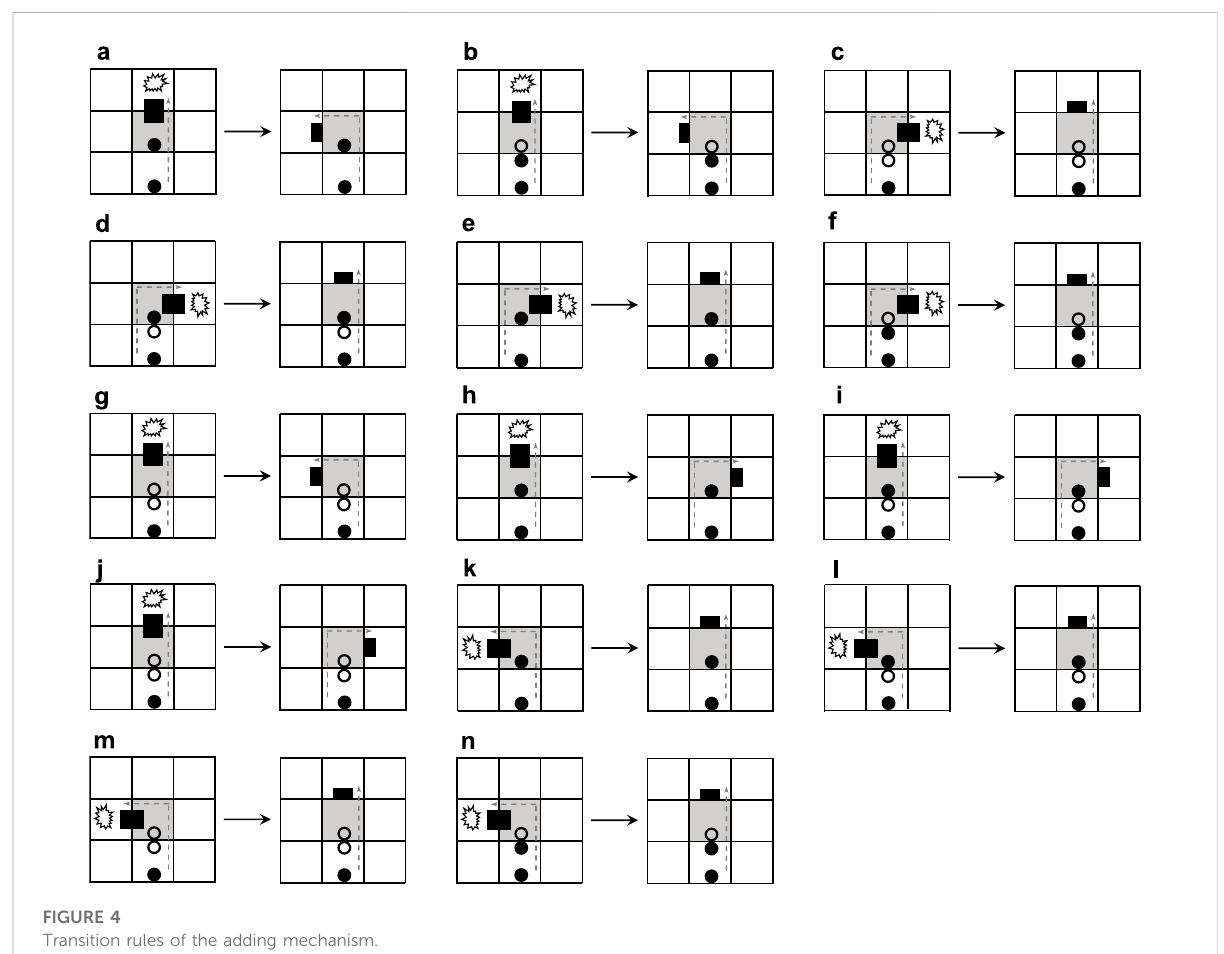
FIGURE 4 Transition rules of the adding